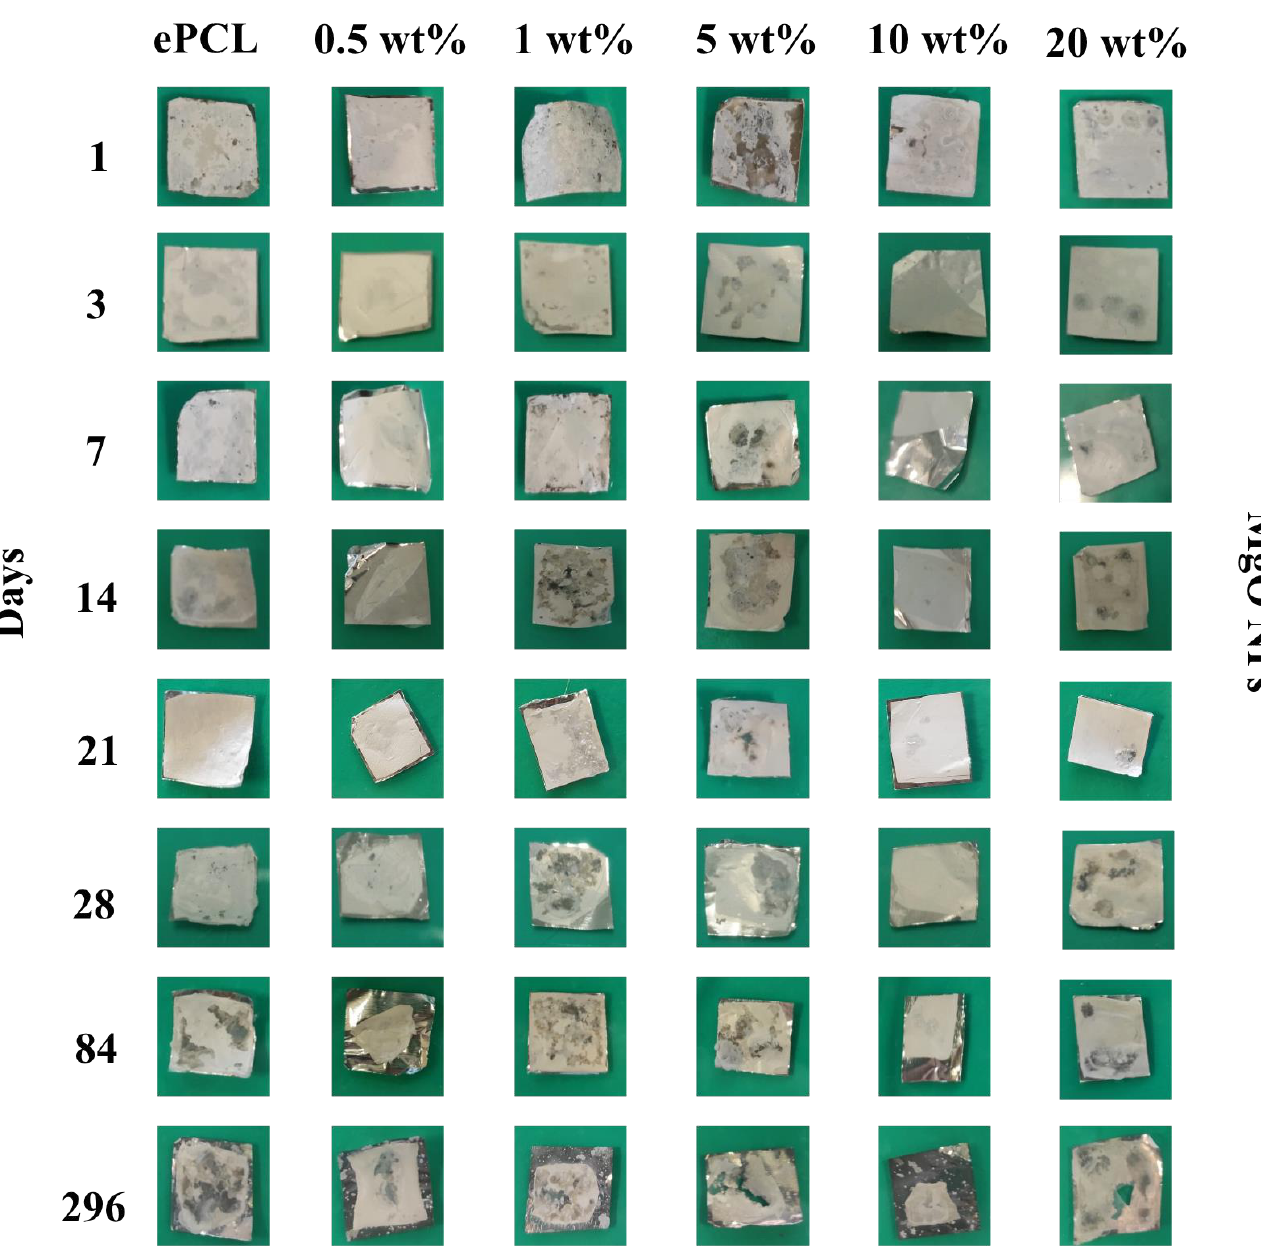
Figure 1. Photos of ePCL and ePCL + MgO NPs at different concentrations and different immersion times.